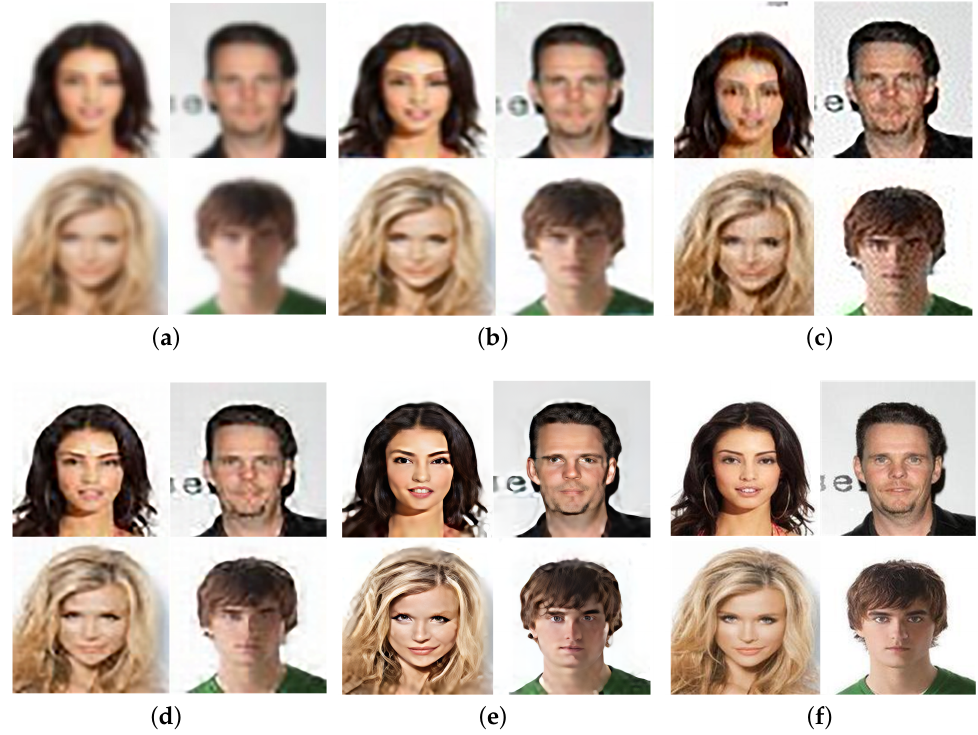
Figure 2. CelebA dataset test results. ( a ) Blur images; ( b ) DeblurGAN-v2; ( c ) Self-Deblur; ( d ) DED; ( e ) Ours; ( f ) Sharp